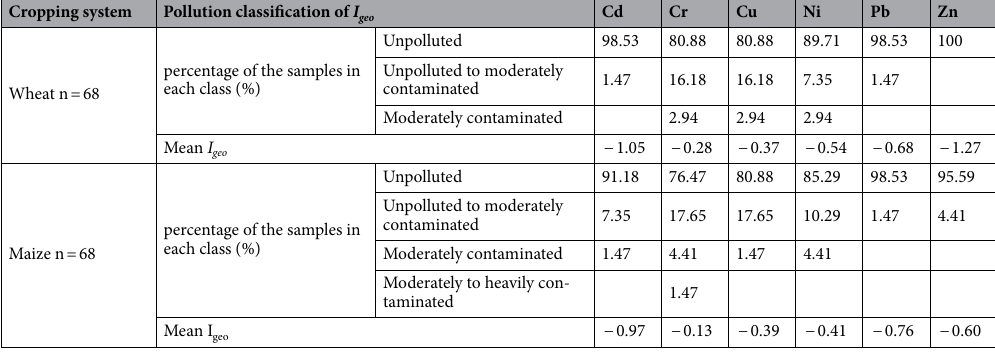
Table 2. Pollution classification of soil heavy metals in wheat and maize cropping systems.